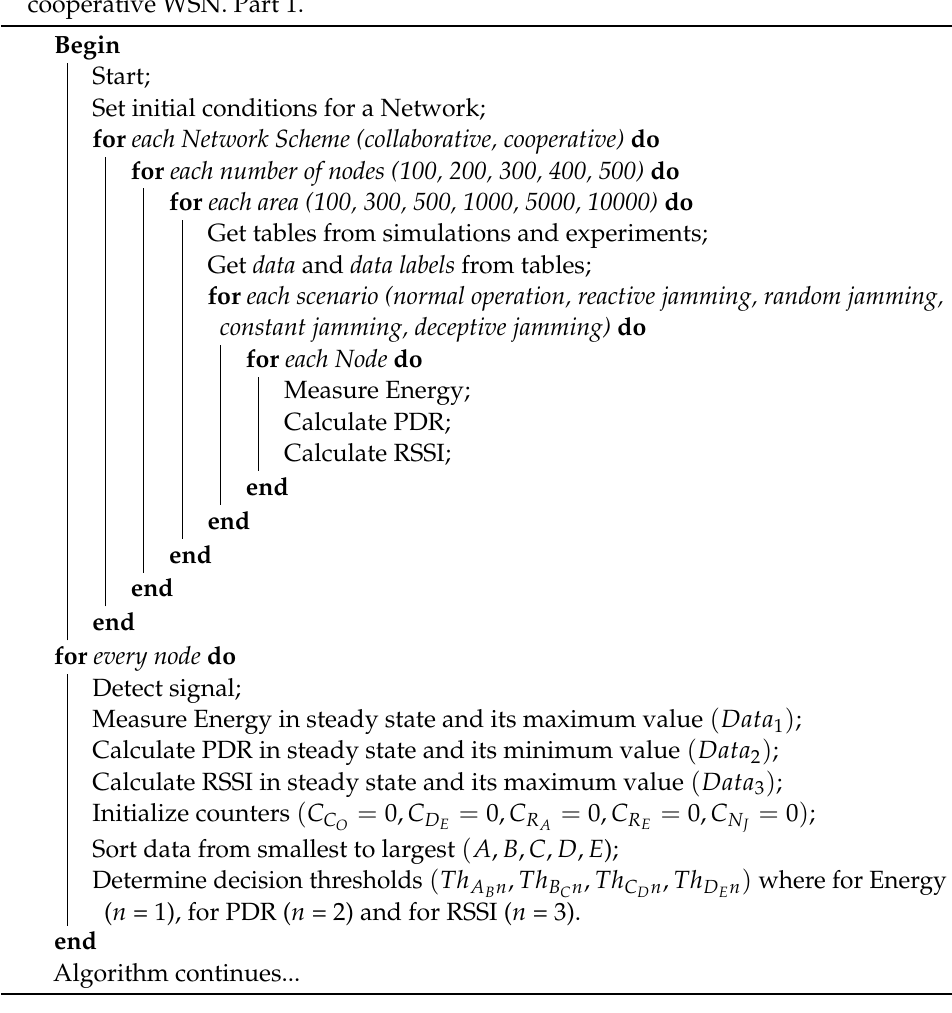
Algorithm 1: Proposed jamming detection algorithm for collaborative and cooperative WSN. Part